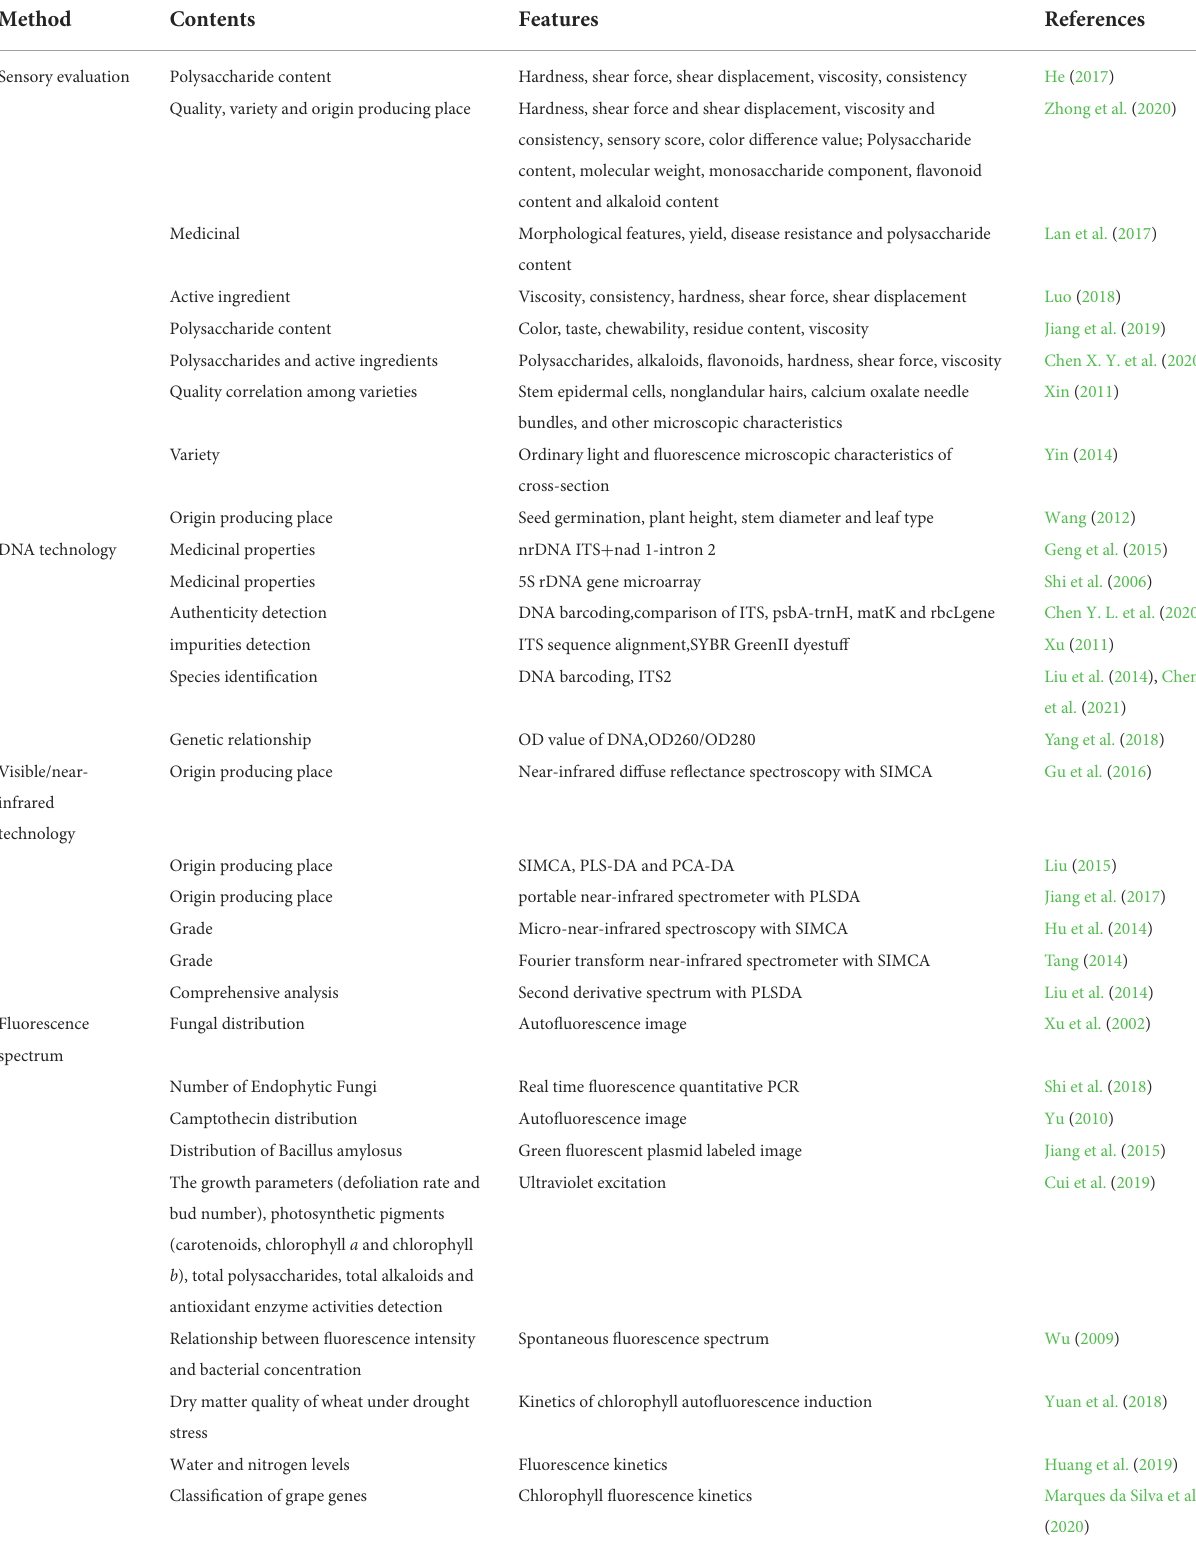
TABLE 5 Different technology in Dendrobium candidum